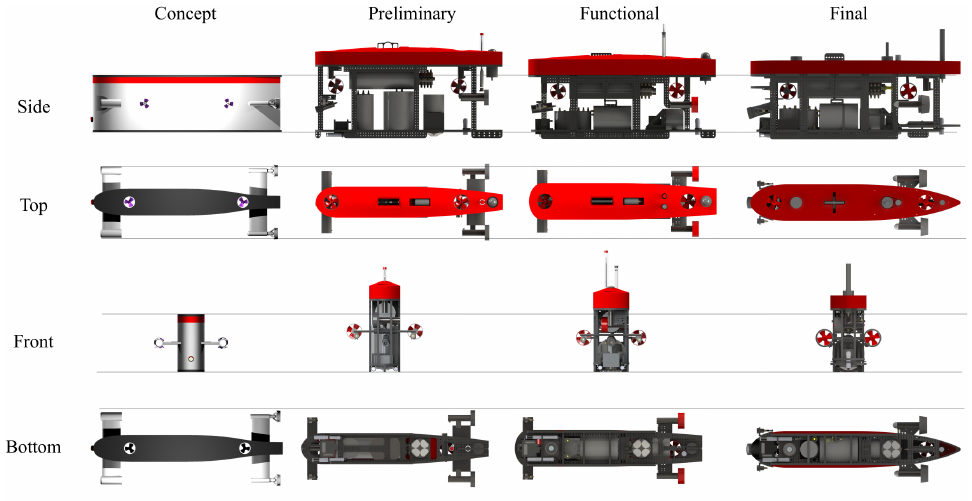
Figure 7. Four stages of design for Blucy